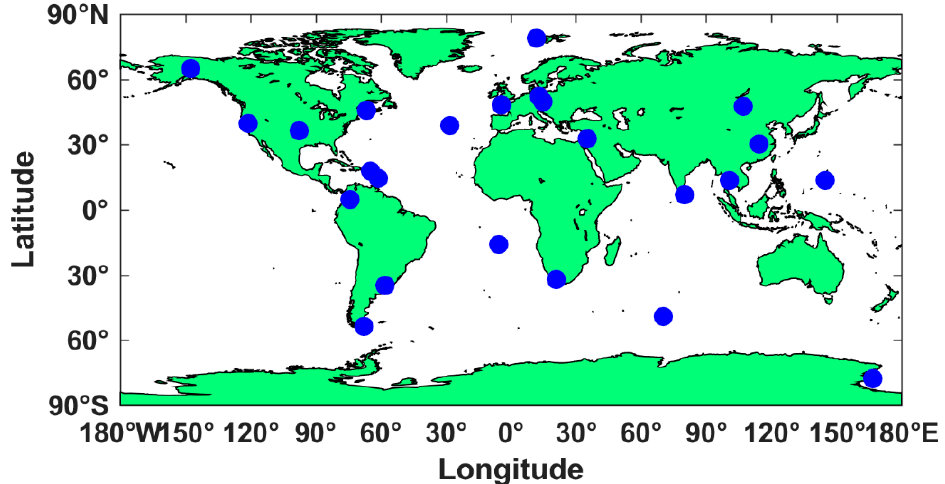
Figure 1. Geographical distribution of the 24 selected MGEX stations.